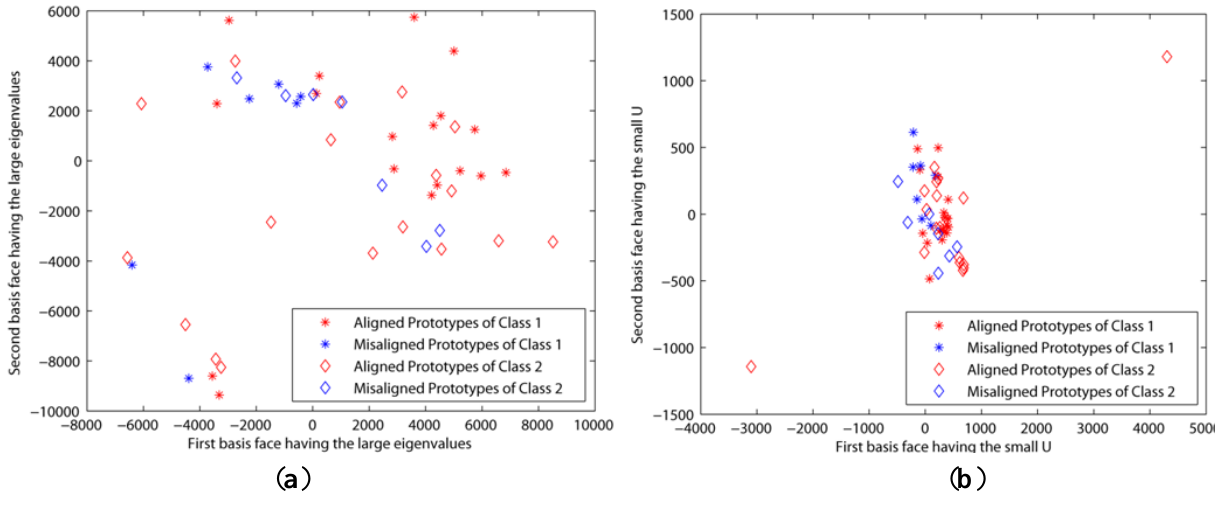
Figure 8. Classification results of Euclidean distances, weight-based distance and RR-based distance ( u = 1.0 e −7, ε = 1.0 e −6, β = 10, k = 100) using subset 2 of CroppedYaleB + misaligned